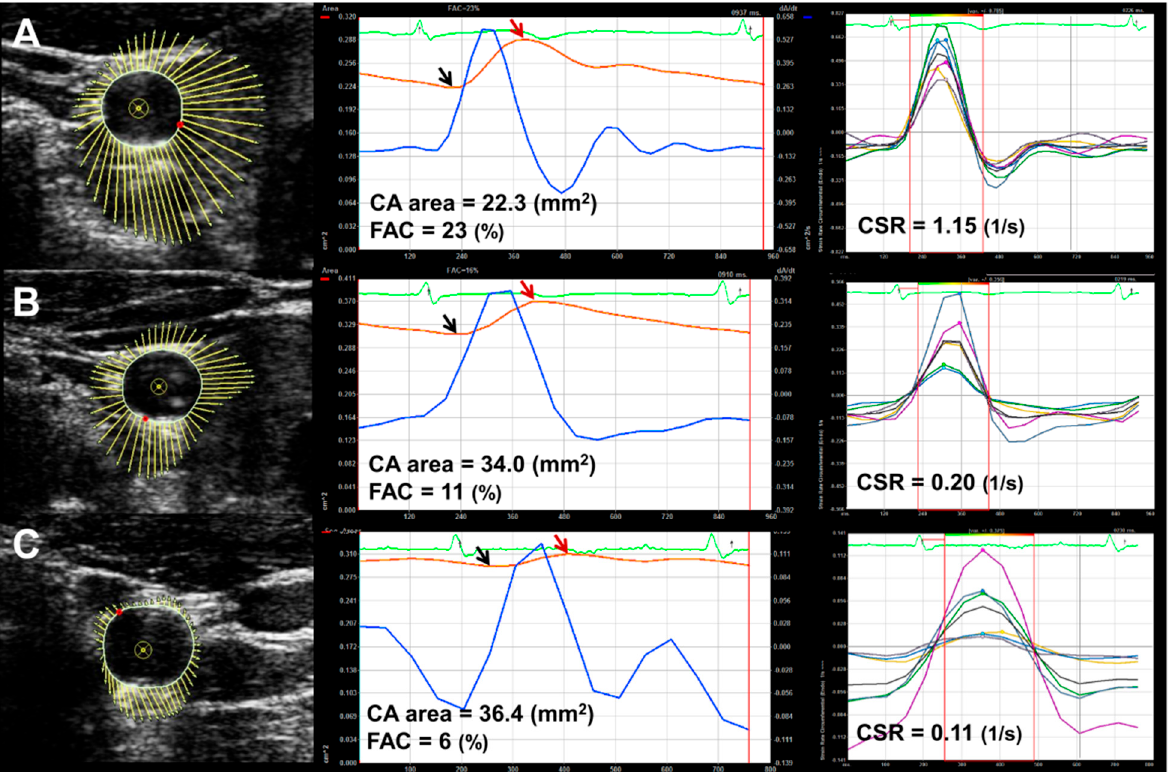
Figure 1. Velocity vector imaging analysis in normal-weight ( A ), overweight ( B ) and obese children ( C ). The red arrow points to maximal CA area and the black arrow points to minimal CA area during the cardiac cycle. CA area refers to minimal CA area (black arrow) and FAC was calculated by measuring the percent changes of the CA area [(maximal area) − (minimal area)/(minimal area)] × 100 (%). CSR refers to average value of peak CSRs of six segments during the systole. Compared to normal-weight children ( A ), overweight ( B ) and obese ( C ) children show an increase in CA area and a decrease in FAC and CSR. CA, carotid artery; FAC, fractional area change; CSR, circumferential strain rate.